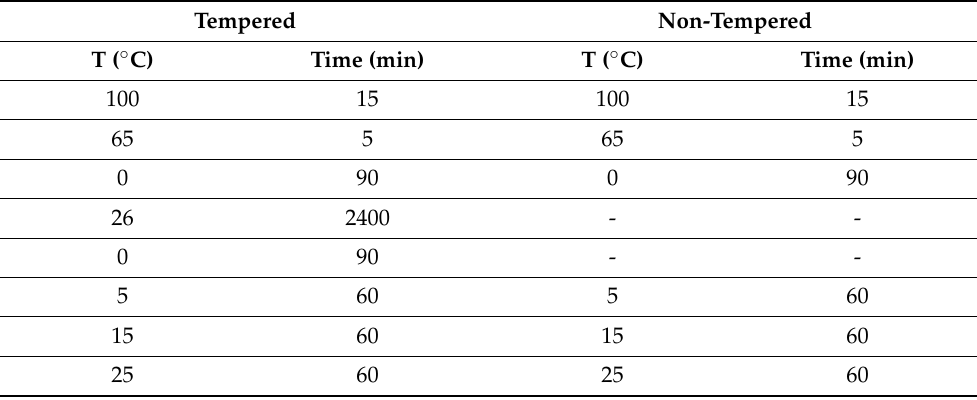
Table 1. Applied temperature profile for tempered and non-tempered cocoa butter. Tempered Non-Tempered T ( ◦ C) Time